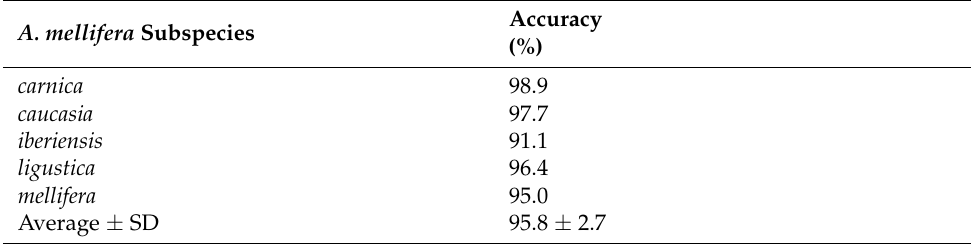
Table 6. Classification accuracy obtained for five A. mellifera